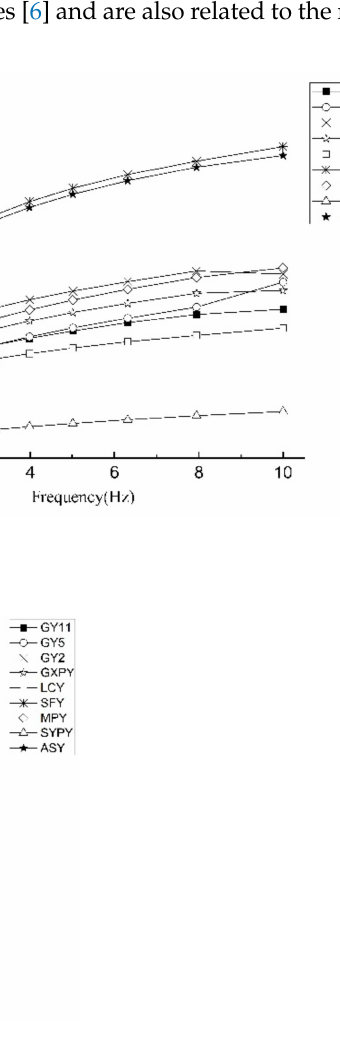
Figure 5. The elastic modulus ( A ), viscous modulus ( B ), and loss tangent angle ( C ) of yam starch. Remarks: G (cid:48) : elastic modulus; G (cid:48)(cid:48) : viscous modulus; tan δ : loss tangent